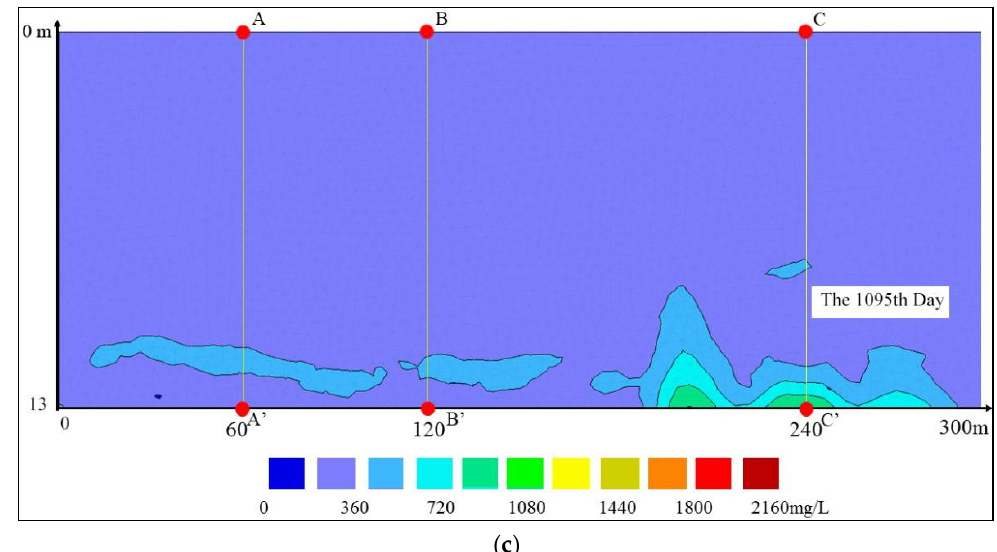
Figure 6. NO 3 − distribution after ( a ) 270 days; ( b ) 365 days; and ( c ) 1095 days.